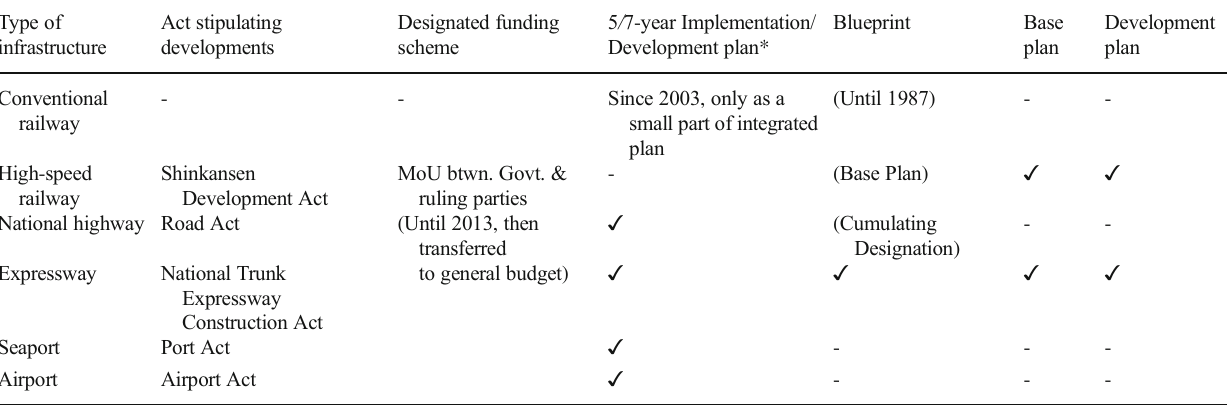
Summary of national-level planning frameworks for each type of transport infrastructures Type of infrastructure